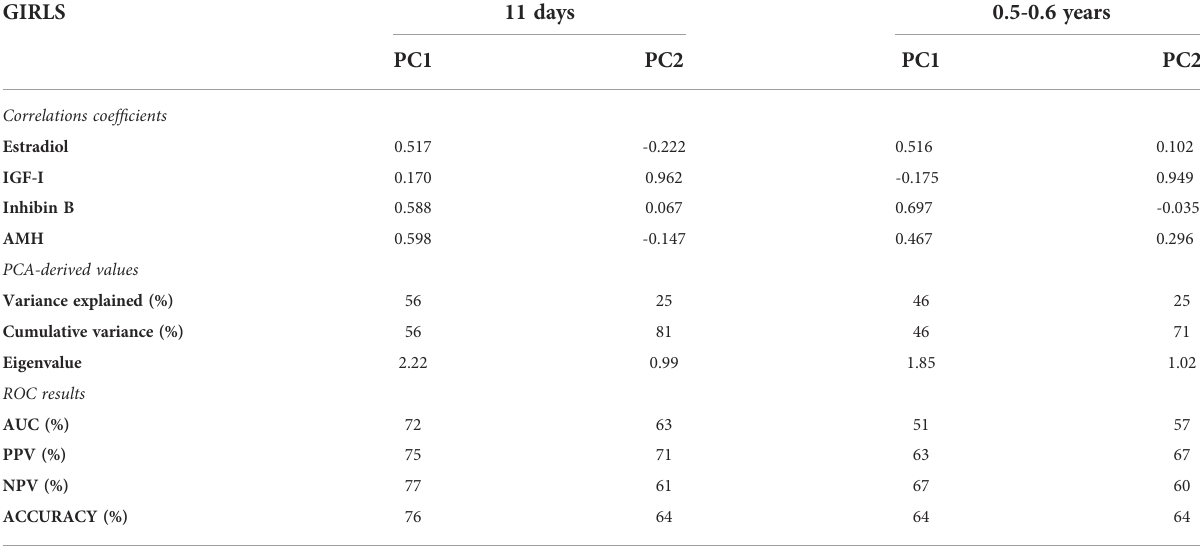
TABLE 4 Principal components and correlation coef fi cients for hormone concentrations in girls at the initial exam (median age: 11 days) and at the exam between 0.5-0.6 years of age. GIRLS